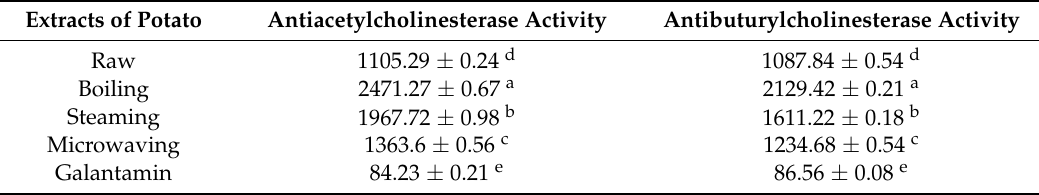
Table 8. Half-maximal inhibitory concentration (IC 50 ) values for anticholinesterase